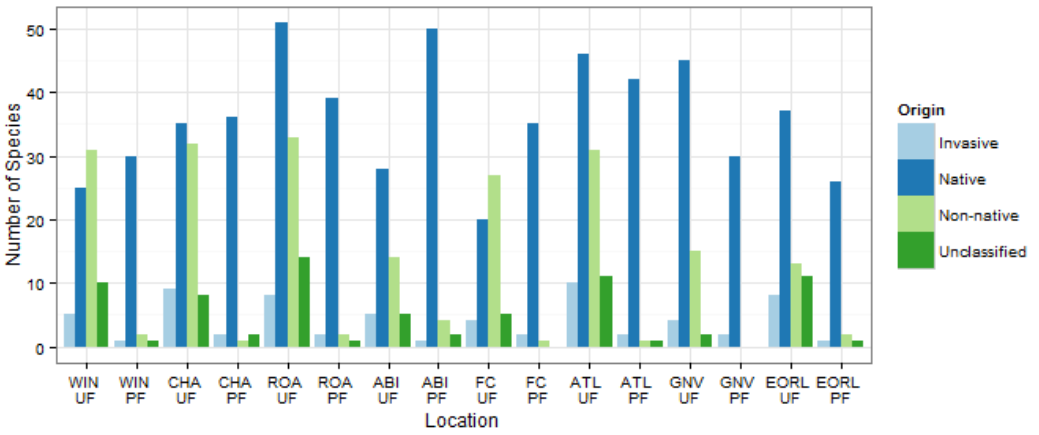
Figure 6. Number of observed species by origin and location. (ATL = Atlanta, GA; CHA = Charlottesville, VA; EORL = East Orlando, FL; FC = Falls Church, VA; GNV = Gainesville, FL; ROA = Roanoke, VA; ABI = Abingdon, VA; WIN = Winchester, VA; UF = Urban forests, PF = Periurban forests.) Locations are listed North-South, with the exception of Falls Church which is listed more southerly to reflect its ecological province.